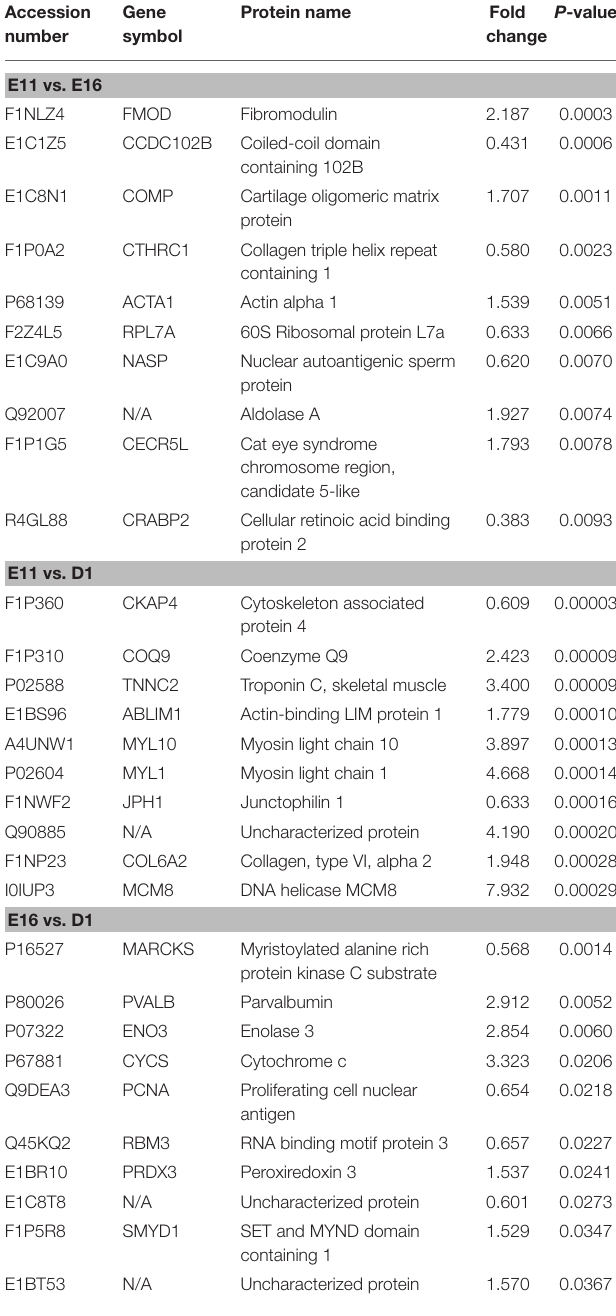
TABLE 1 | The top 10 differentially expressed proteins in E11 vs. E16, E11 vs. D1, and E16 vs. D1